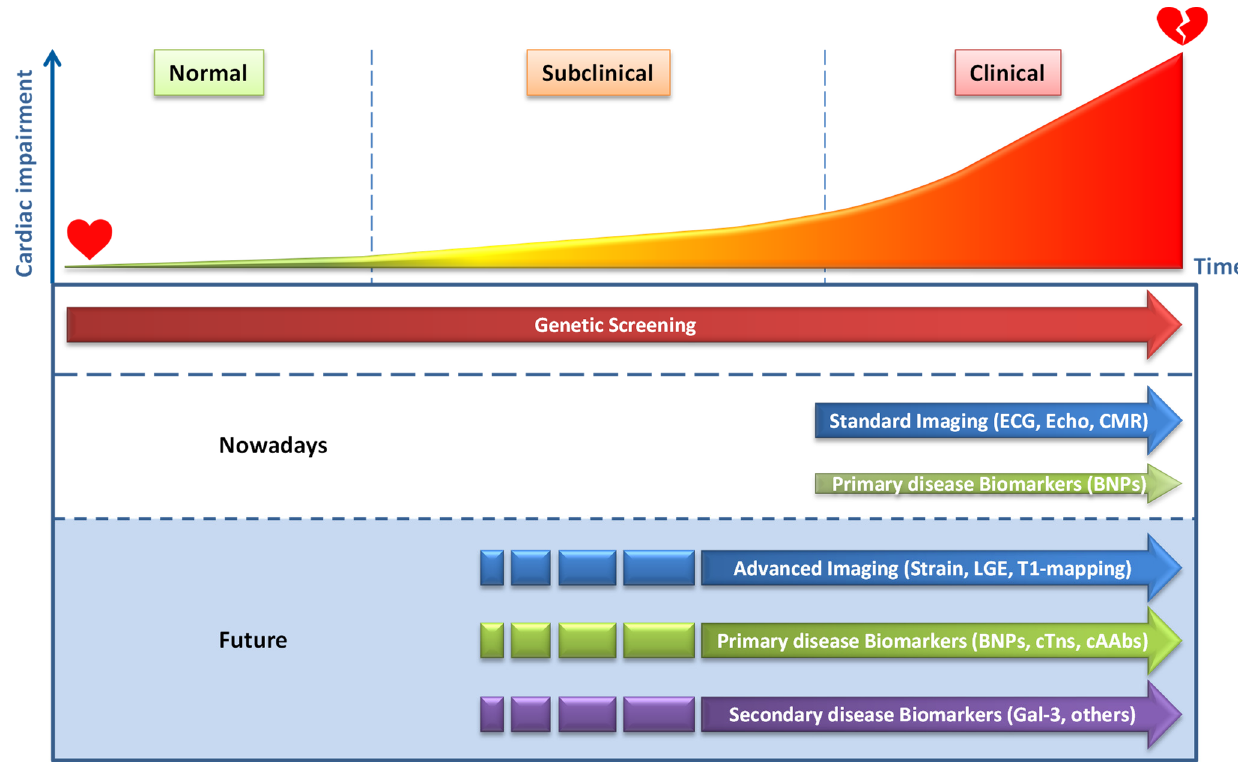
Figure 3. Moment of disease detection in relation to the level of cardiac impairment. ECG = electrocardiogram; Echo = echocardiography; BNPs = B-type natriuretic peptide and N-terminal pro BNP; LGE = late gadolinium enhancement, cTns= cardiac-specific Troponin I and T; cAAbs = cardiac autoantibodies; Gal-3 = galectin-3; Others include GDF15 and sST2.